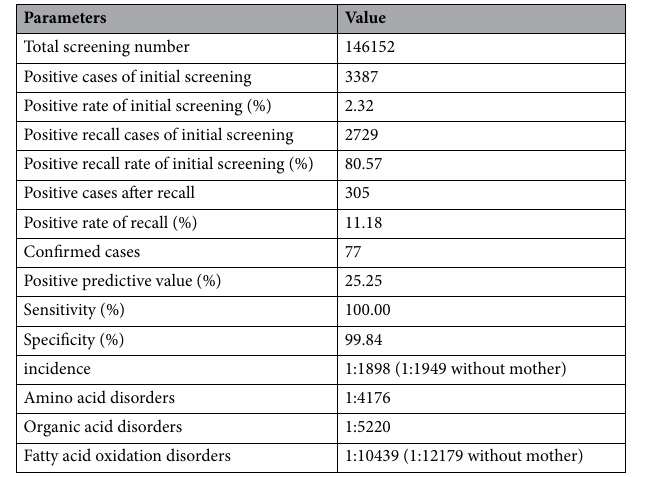
Table 2. Parameters of the expanded newborn screening